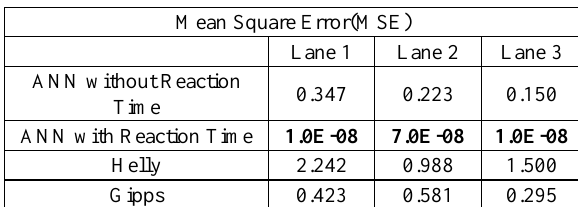
Figure 5. The best validation performance (Lane 1) The outputs of the conventional models were then compared to the outputs of the proposed method in Figure.6.